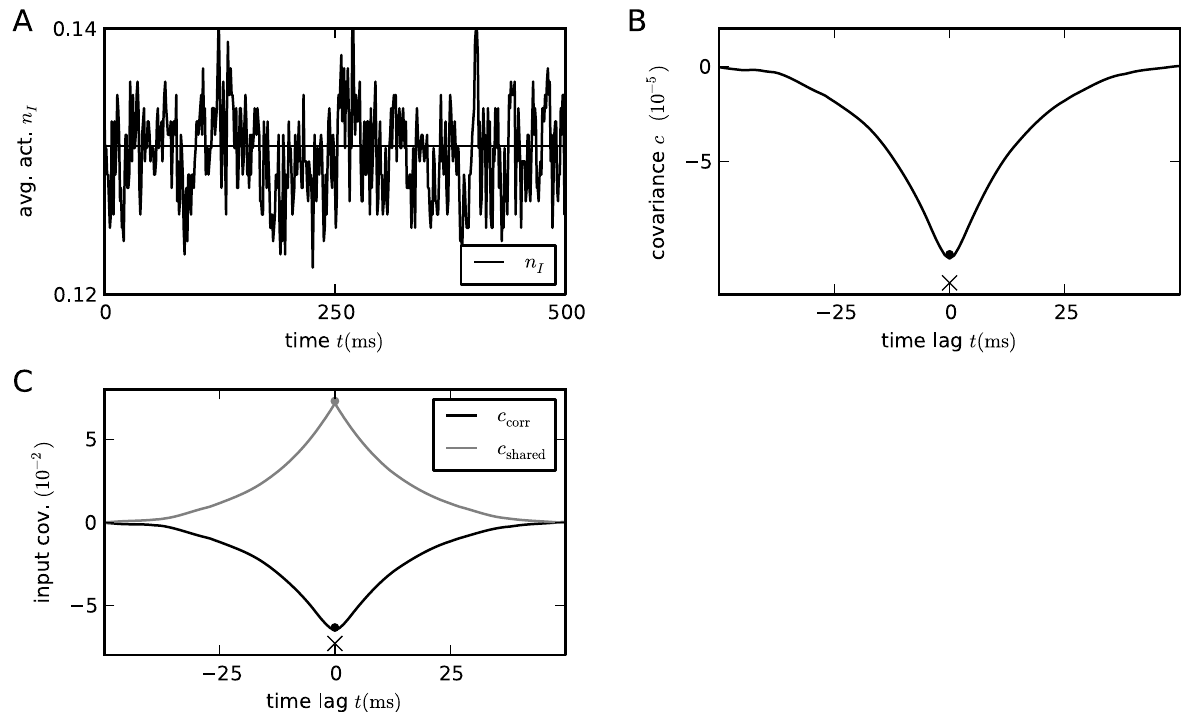
Figure 5. Suppression of correlations by purely inhibitory feedback in absence of external fluctuations. Activity in a network of 8 ~ pN randomly drawn inputs (fixed in-degree) with N ~ 1000 binary inhibitory neurons with synaptic amplitudes J ~{ ffiffiffiffiffi N p . Each neuron receives K p ~ 0 : 1 . A Population averaged activity. Numerical solution of mean field equation (7) (solid horizontal line). B Cross covariance between inhibitory a . C Correlation between the input currents neurons. Theoretical result (32) shown as dot. St. Andrew’s Cross indicates the leading order term c ~{ N to a pair of excitatory neurons. The black curve is the contribution due to pairwise correlations c corr , the gray curve is the contribution of shared input c shared . The dot symbols show the theoretical expectations (33) based on the leading order (crosses) and based on the full solution (32) (dot). 1 1 pNJ z J Threshold of neurons h ~ 10 2